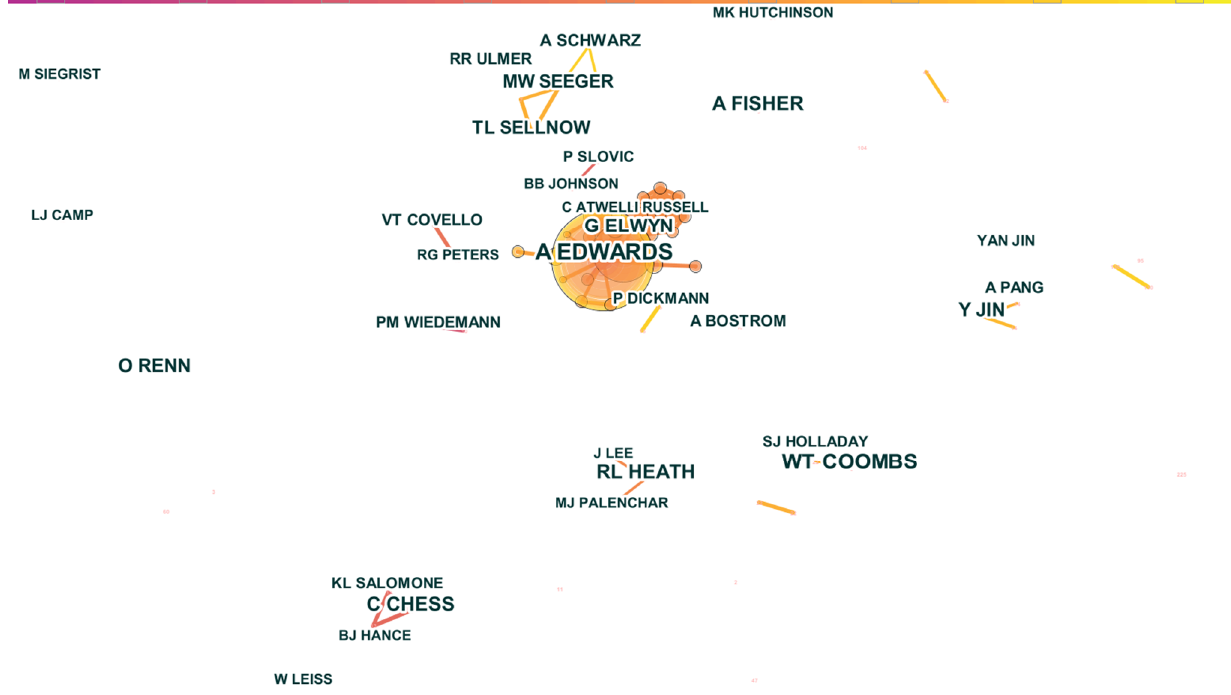
Figure 6. Map of the author co-authorship network of crisis and risk communication research. As shown in Table 5, the betweenness centrality of all authors is 0, indicating that no author acts as a “bridge” in this field. Our in-depth analysis of the top 10 most prolific authors is shown below. Table 5. Top 10 most productive authors in crisis and risk communication